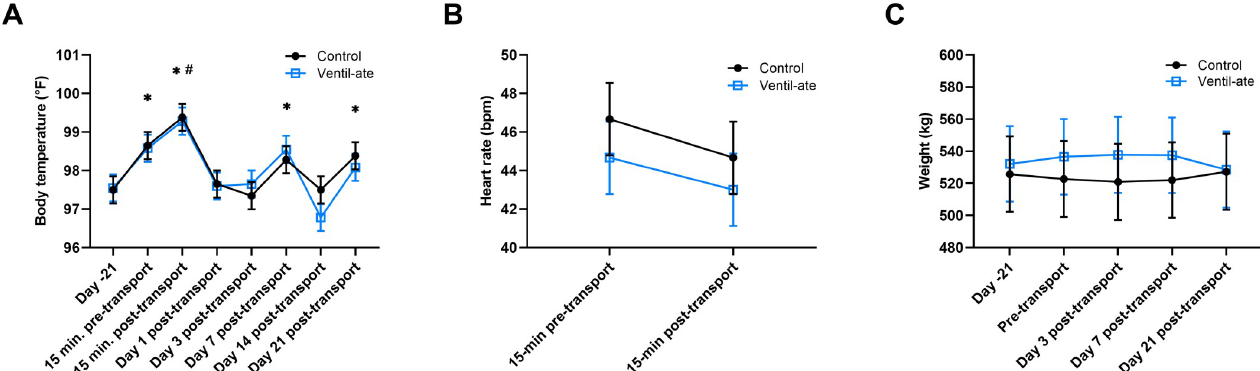
Fig 1. (A) Body temperature, (B) heart rate, and (C) body weight. For illustrative purposes, the results (least squares means ± SE) shown are from the analyses that included the group-by-time interaction; however, the significant differences noted on the figure were determined from the analysis with only group and time included as main effects. (A) No significant group ( P = 0.9105) or group-by-time ( P = 0.8787) effects were observed; a significant time effect was observed ( P < 0.0001). � denotes a significant difference ( P < 0.05) from baseline (Day –21). # denotes a significant difference ( P < 0.001) from all other time points. (B) No significant group ( P = 0.4316), time ( P = 0.2043), or group-by-time ( P = 0.9091) effects were observed. Bpm, beats per minute. (C) No significant group ( P = 0.8464), time ( P = 0.9878), or group-by-time ( P = 0.4057) effects were